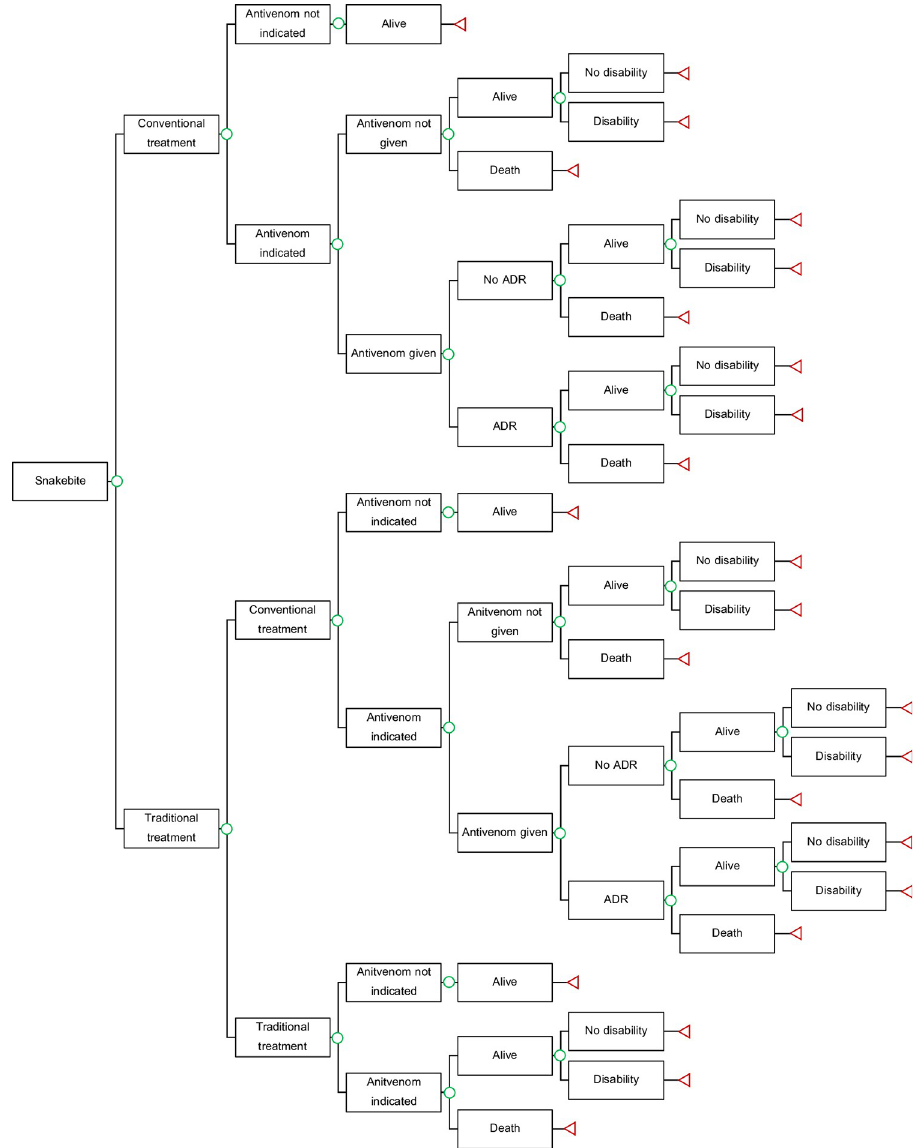
Fig 1. Decision tree to estimate economic and disease burden of snakebite in ASEAN countries. Abbreviation: ADR–adverse drug reaction.